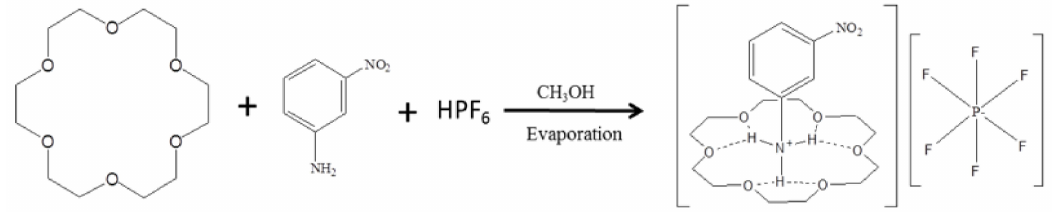
chain structure. Figure S5. View of 3-nitroanilinium cation of compound 1. Figure S6. Dihedral angle of benzene and –NO2 group of the super-molecular cation. Figure S7. Model structure of compound 1 for the potential energy calculations. Table S1. Hydrogen-bond geometry (Å ◦ ) for complex 1. Table S2. Selected bond distances and angles for compound 1 (Å ◦